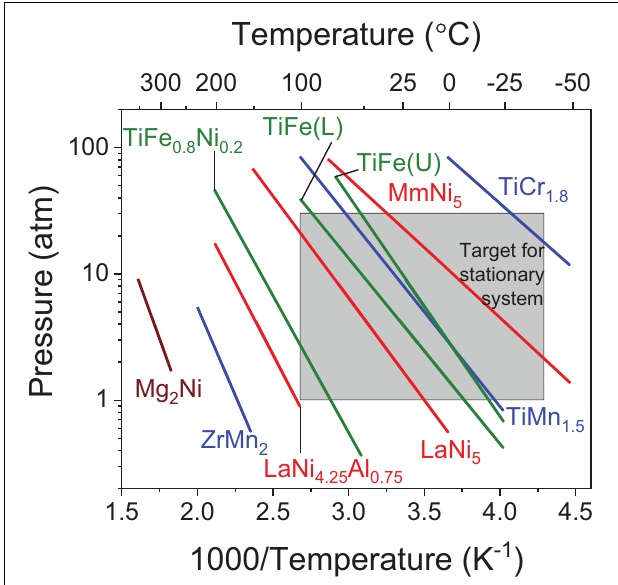
FIGURE 5 | Van’t Hoff plots showing examples of decomposition plateau of common intermetallic hydrides with the estimated targets for stationary application (shown in Table 2 ); [color scheme: AB (green), AB 2 (blue), A 2 B (brown), and AB 5 (red)]; (L) indicates lower plateau, (U) indicates upper plateau and Mm represents Mischmetal (Sandrock, 1999; Broom,